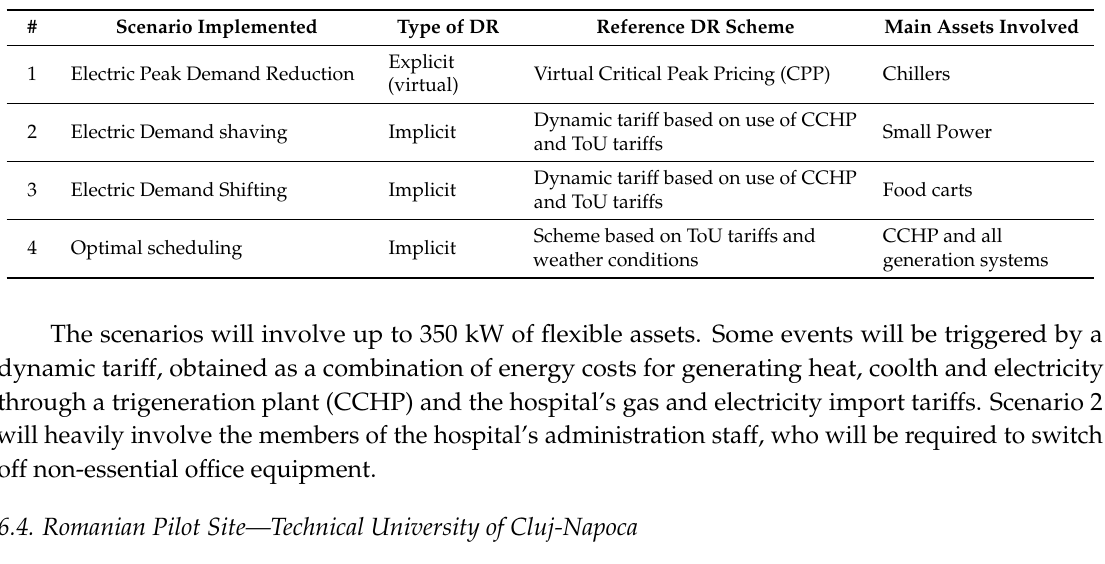
Table 3. DR scenarios and scheme implemented in the Italian pilot site.